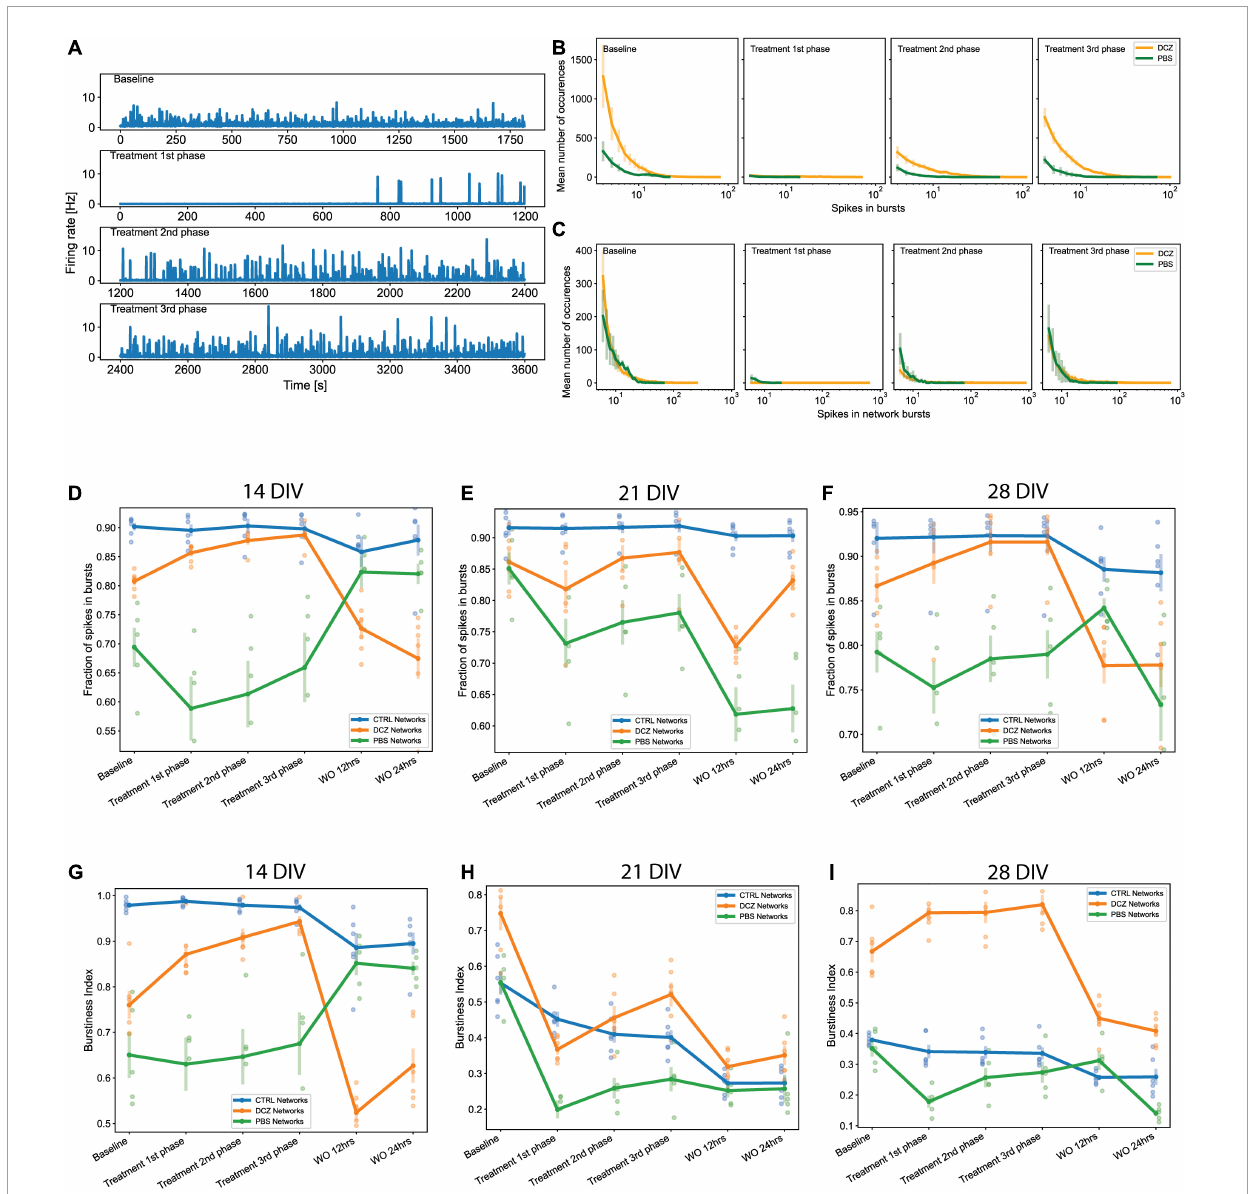
FIGURE6 Neural network activity at baseline and in response to designer receptors exclusively activated by designer drugs (DREADDs)-mediated inhibition of excitatory synaptic transmission. Each panel in (A) show a trace generated from 64 recording channels of spontaneous activity of one DCZ treated network at 28 DIV. The first panel shows the 20 min recording of the spontaneous firing rate at baseline, the second, third and fourth panels show the 1st, 2nd, and 3rd phases of 20 min recordings of spontaneous activity during DCZ treatment. The x -axis denotes time in seconds and the y -axis denotes firing rate in Hz. (B) The spikes in bursts and (C) network bursts for the baseline, 1st, 2nd, and 3rd phase recordings are shown for sample DCZ treated networks ( n = 3) and for sample PBS vehicle networks ( n = 2). The x -axis denotes the number of spikes, and the y -axis denotes the number of burst occurrences of a given number of spikes. (D–F) Plots of the fraction of spikes in bursts across baseline, treatment and recovery recordings at 14, 21, and 28 DIV for all network groups ( n = 6 for CTRL and DCZ, and n = 5 for PBS). The x -axis denotes the recording condition, and the y -axis denotes the percentage of spikes located in bursts. (G–I) Plots depicting burstiness of each network group across the baseline, treatment and recovery recordings at 14, 21, and 28 DIV. The x -axis denotes the recording condition, and the y -axis denotes the burstiness index as the fraction of activity in the 15% most active time windows. The solid lines and solid circles plot the mean values for all networks in one group, the shaded bars show the standard error of the mean, and the shaded circles show the individual data